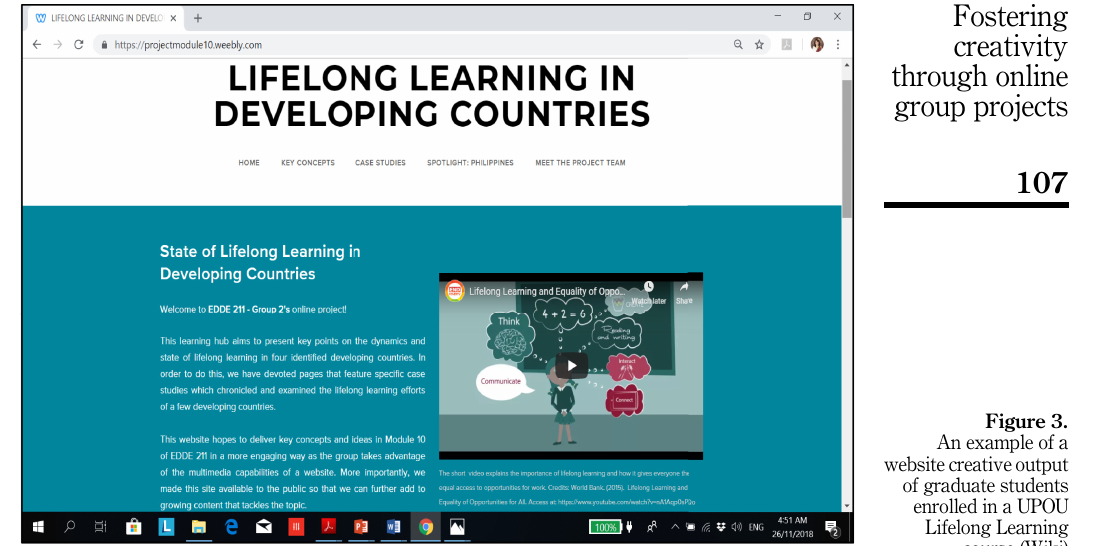
Figure 3. An example of